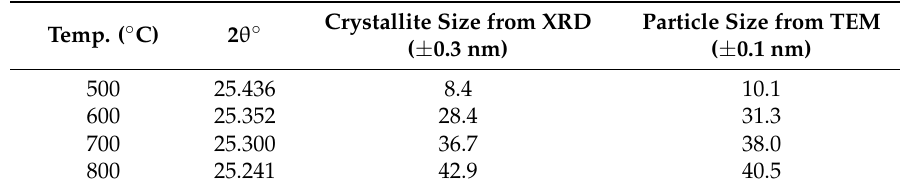
Table 1. The calculated crystallite sizes and particle size of TiO 2 corresponding to different calcination temperatures.